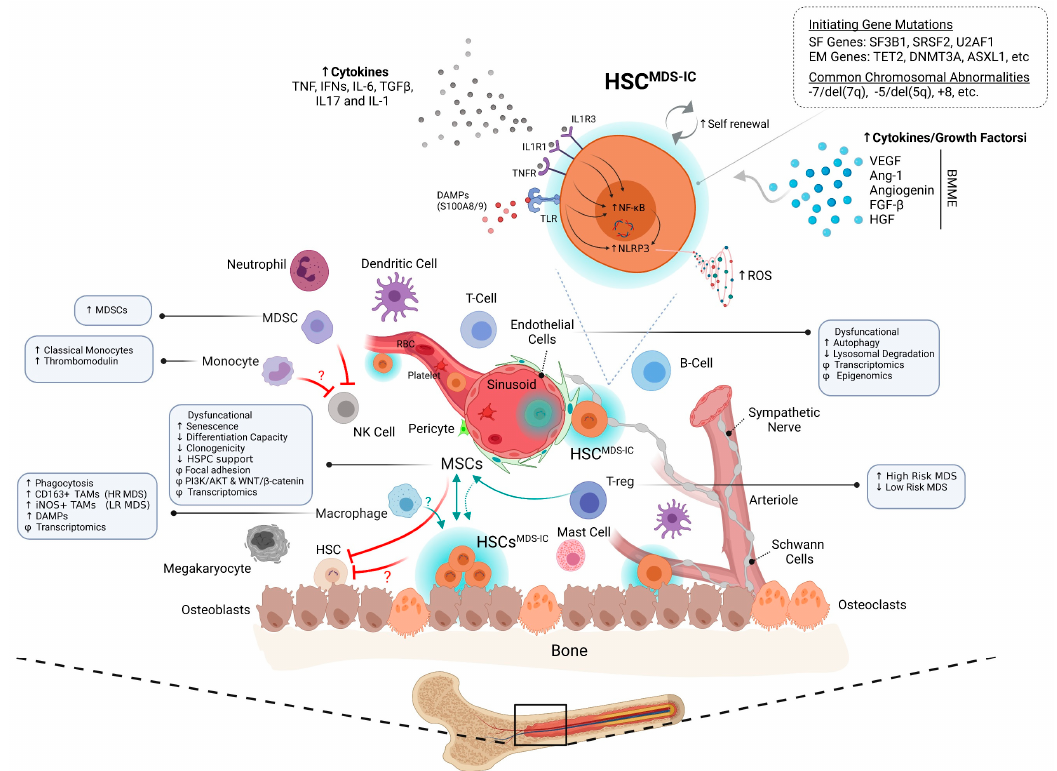
Figure 2. Overview of the MDS bone marrow (BM) cellular metropolis. BM microenvironment is home to multitude of different types of cells including haematopoietic stem cells (HSCs), megakaryocytes, arteriolar and sinusoidal type endothelial cells, osteolineage cells, osteoclasts, osteoblasts, non-myelinating Schwann cells and mesenchymal stromal cells (MSCs). Other cell types that reside in these BM microenvironments are immune-related cells, such as myeloid derived suppressor cells (MDSCs), regulatory T cells (T-regs), dendritic cells, neutrophils, natural killer cells, monocytes and macrophages that primarily form the ‘immuno-microenvironment’. Altogether the interplay between all the components contributes to bone homeostasis as well as the tight regulation of the HSCs (i.e., their homing, quiescence, self-renewal capacity and long-term multilineage repopulation ability), therefore maintaining them in a steady state. MDS-initiating cells (MDS-ICs) with increasing self-renewal capacity are constantly interacting with the cells in the surroundings. MDS-ICs coexist alongside normal wildtype healthy HSCs, which are supressed via an unknown mechanism. MDS-ICs and MSCs are shown to have a bi-directional crosstalk between them. MSCs and endothelial cells themselves have been shown to be dysfunctional. T-regs have been shown to indirectly influence MDS-ICs via MSCs. In MDS bone marrow, a significant increase in the MDSCs and monocytes has been observed. Macrophages seem to have acquired increasing ability for phagocytosis. Abnormal levels of cytokines, growth factors and reactive oxygen species (ROS) are present in the MDS BMME that directly influence the MDS ‐ ICs via various receptors, therefore activating numerous intrinsic pathways (Inflamma ‐ tory, etc.) in these cells. Φ = Disrupted; ↑ = Increase, ↓ = Decrease, ‐ = deletion. Illustration was created with BioRender.com (accessed on 28 June 2021).